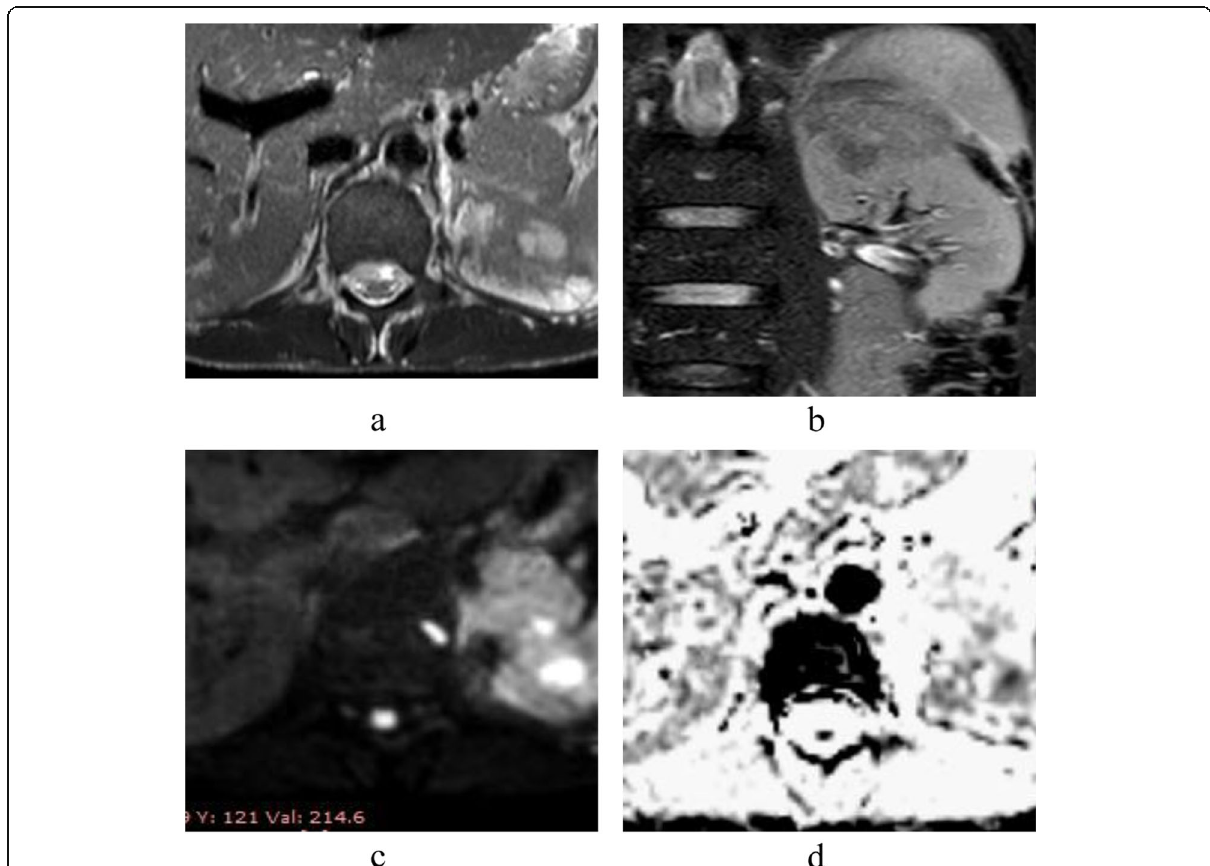
Fig. 10 A 43-years-old male coming with left loin pain, fever, malaise. a , b T2 WI axial and sagittal showing a left upper pole heterogeneous lesion with central fluid intensity, c , d DWI with ADC showing restricted diffusion among the central fluid; ADC = 0.8 × 10 − 3 mm 2